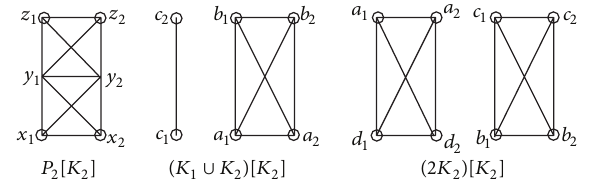
Figure 1: Graphs 𝑃 2 [𝐾 2 ] , (𝐾 1 ∪ 𝐾 2 )[𝐾 2 ] , and (2𝐾 2 )[𝐾 2 ] .